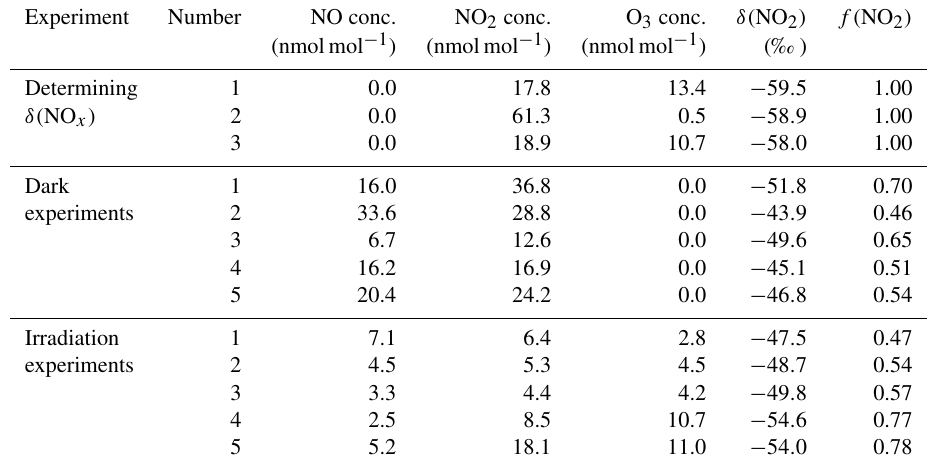
Table 1. Experimental conditions; concentrations of NO, NO 2 and O 3 at a steady state; and measured δ( NO 2 ) values.